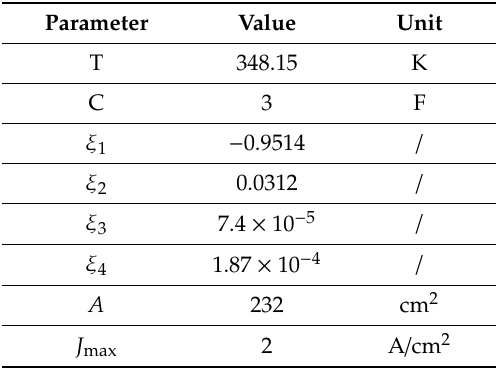
Table 1. The fuel cell parameter